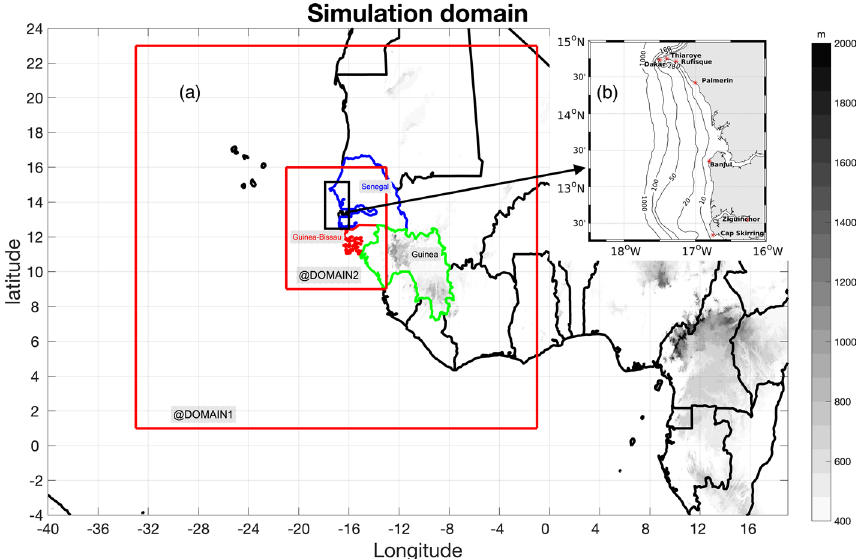
Fig. 1 a Map of West Africa including the simulation domains and the orography. The red larger represents the domain 1 and the smaller red rectangle is for domain 2. b Bathymetry (in dashed line) and location of observed dam- ages (in red point) during the passage of the Hurricane Fred along the Senegalese